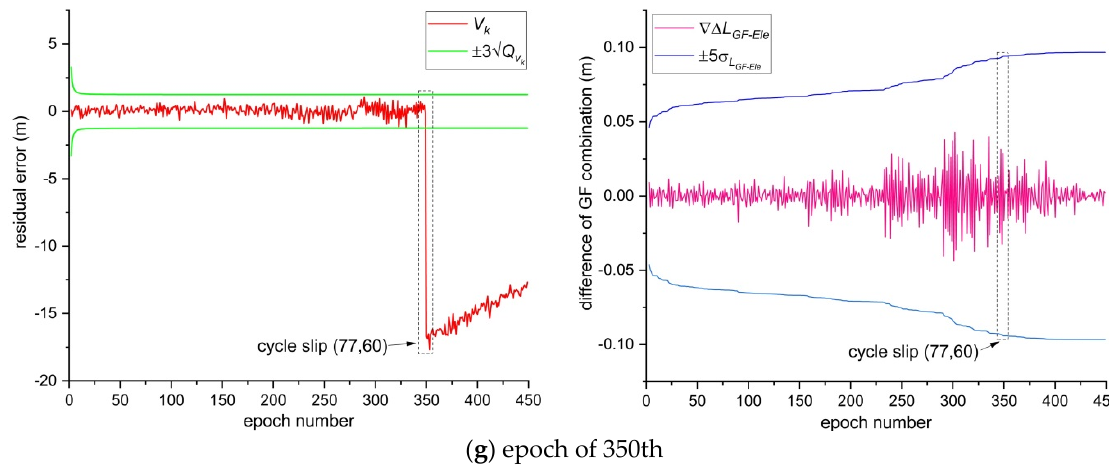
Figure 9. Cycle slip detection results of satellite G09 at different epochs under normal environment.